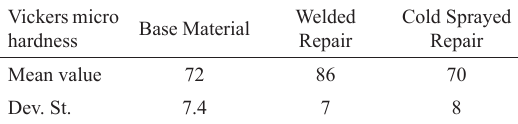
Table 2: Results of the microhardness